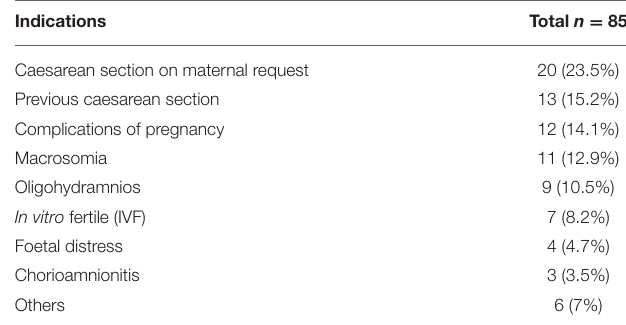
TABLE 1 | Clinical characteristics of pregnant women who attended to a pre-natal education course. Maternal age (years, mean/SD)